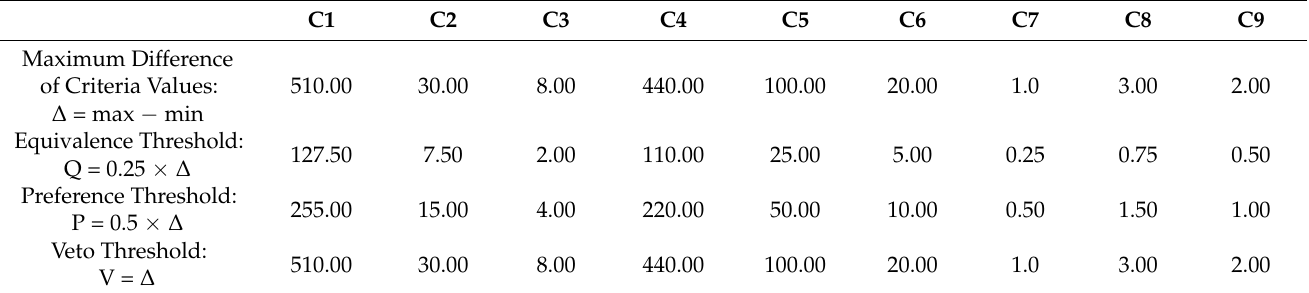
Table 4. The values of the indicators: equivalence, preference and veto thresholds.